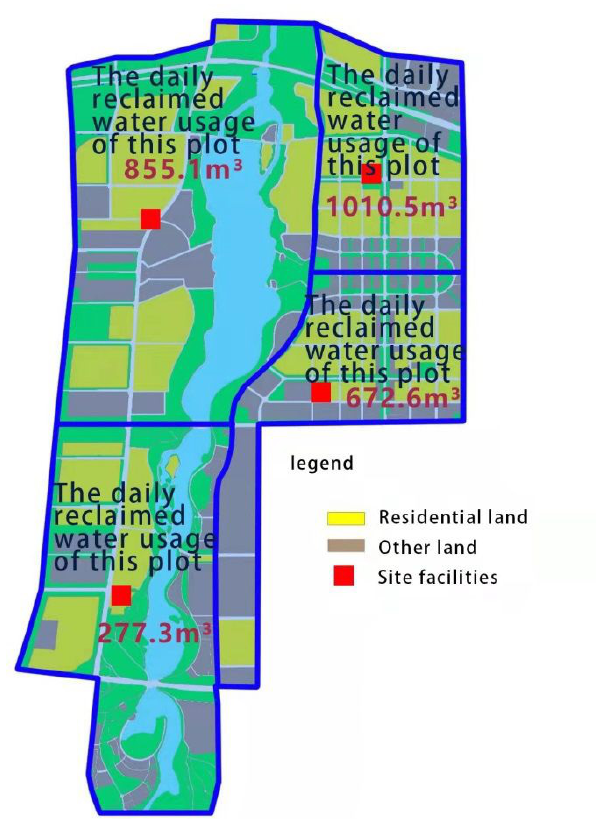
Fig. 1 Schematic diagram of the distribution of water treatment groups in the Green Ecological City of Zhangqiu Shuyuan